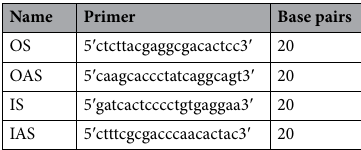
Table 1. HCV 5 ʹ UTR primers and